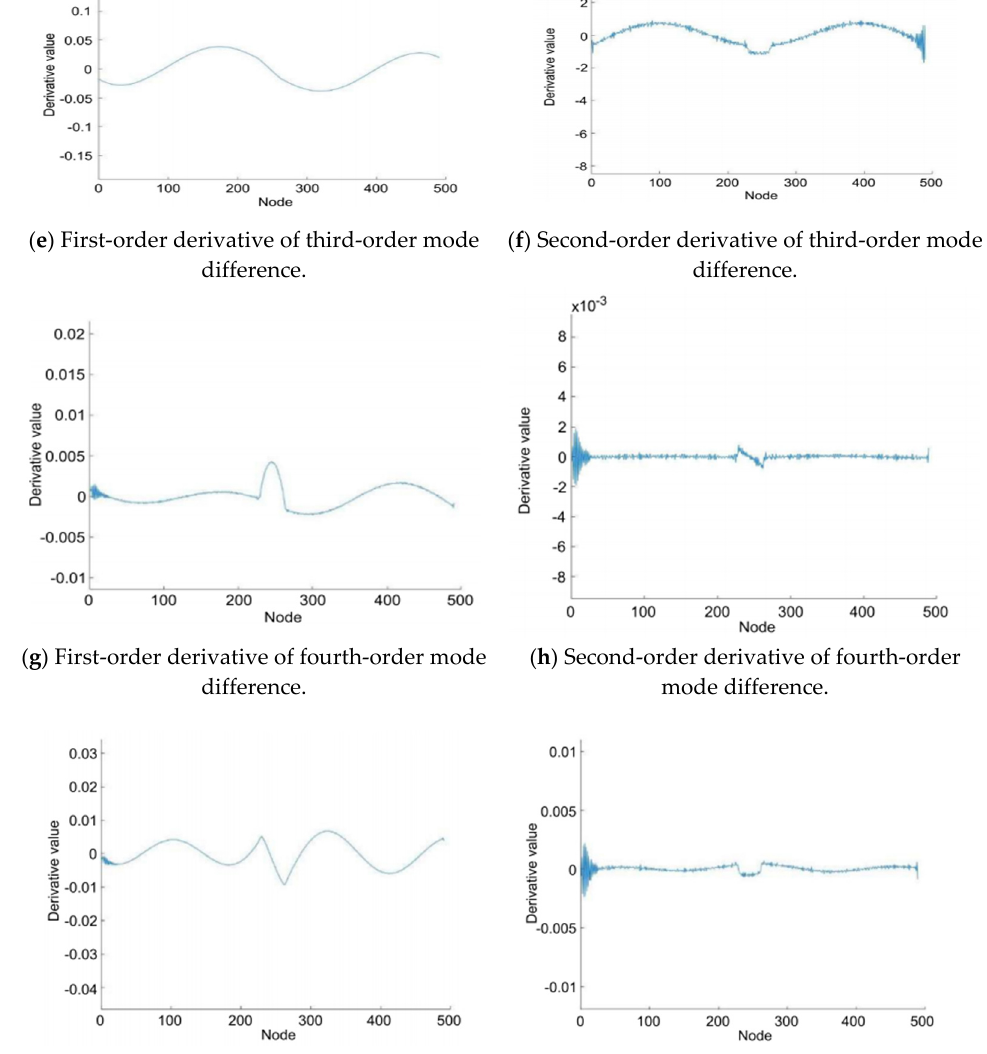
Figure 25. First-order and second-order derivatives of the differences of the first five orders of modes under Conditions 1 and 4.